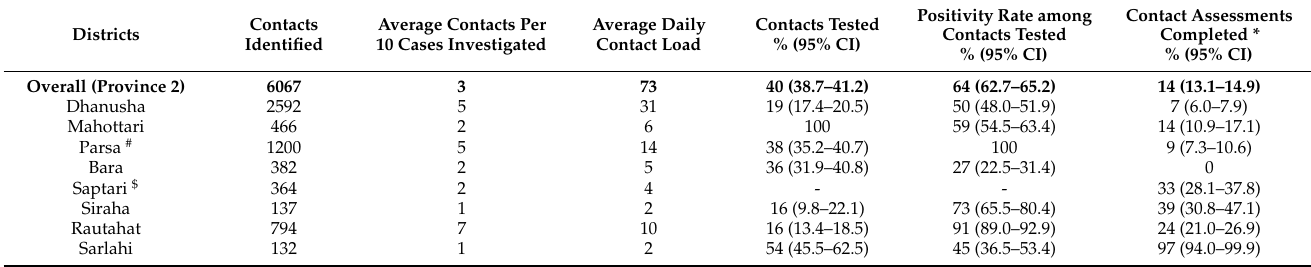
Table 2. District-wide variations in identification, testing, positivity rates and completion of 14-day follow-up for contacts via the CICT program in Province-2 of Nepal between May to July